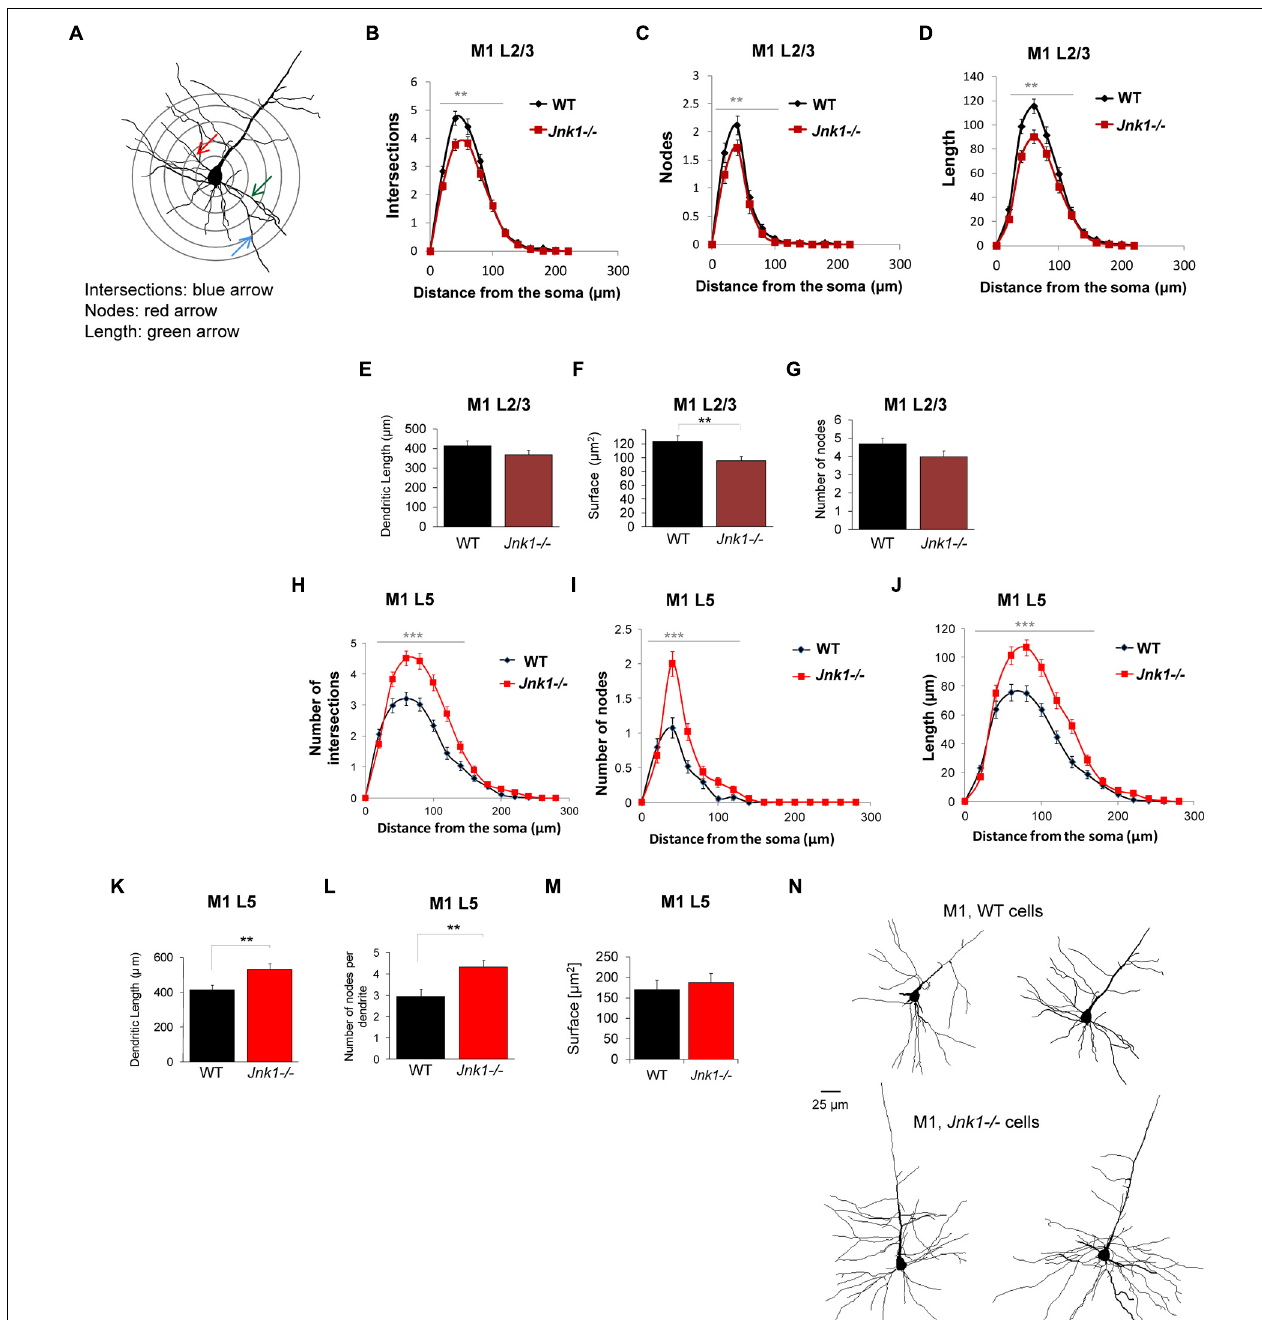
from M1, there was a significant increase in dendrite complexity exemplified as increased number of intersections, nodes and increased dendrite length in Jnk1-/- brains compared to wild-type. (K–M) The total dendritic tree length, number of nodes per tree and total surface area is shown. (N) Neurolucida tracings from M1 L5 neurons in WT and Jnk1-/- mice are shown. Means ± SEMs are indicated. For L2/3 neurons 81 WT and 61 Jnk1-/- dendritic trees were analyzed from a total of 67 cells. For L5 neurons, 49 WT and 63 Jnk1-/- trees were analyzed from a total of 47 cells. For (B–D,H–J) , significance was determined using one-way ANOVA. For (E–G,K,L) , significance was determined using Student’s t -test. Significance levels are ** p < 0.01; *** p <